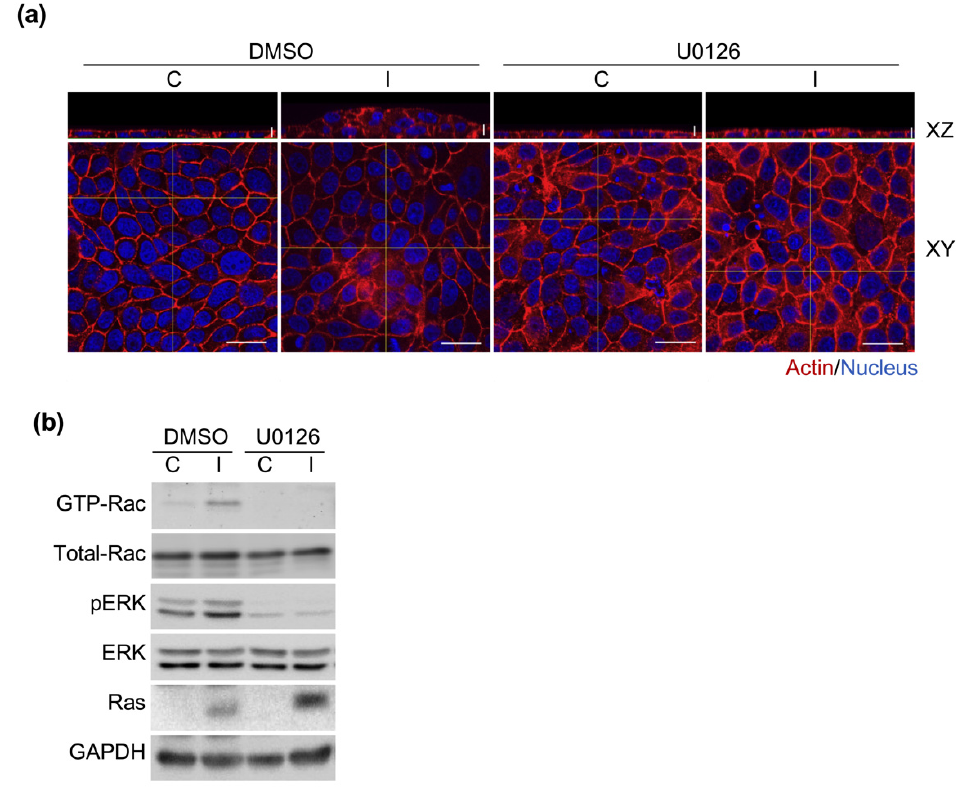
Figure 7. Ha-Ras V12 triggered Rac activity through the MEK pathway. MK4 cells were treated with or without U0126 (20 µM) before administering with or without IPTG (5 mM) for a further 24 h: ( a ) Representative confocal images and xz cross-section images of MK4 cells at the confluent stage, which were stained with Phalloidin (red) and Hoechst 33,258 (blue). Scale bar = 20 µm; ( b ) Results of representative immunoblots for GTP-Rac, Rac, pERK, ERK, and Ras. GAPDH served as the inter- nal control.